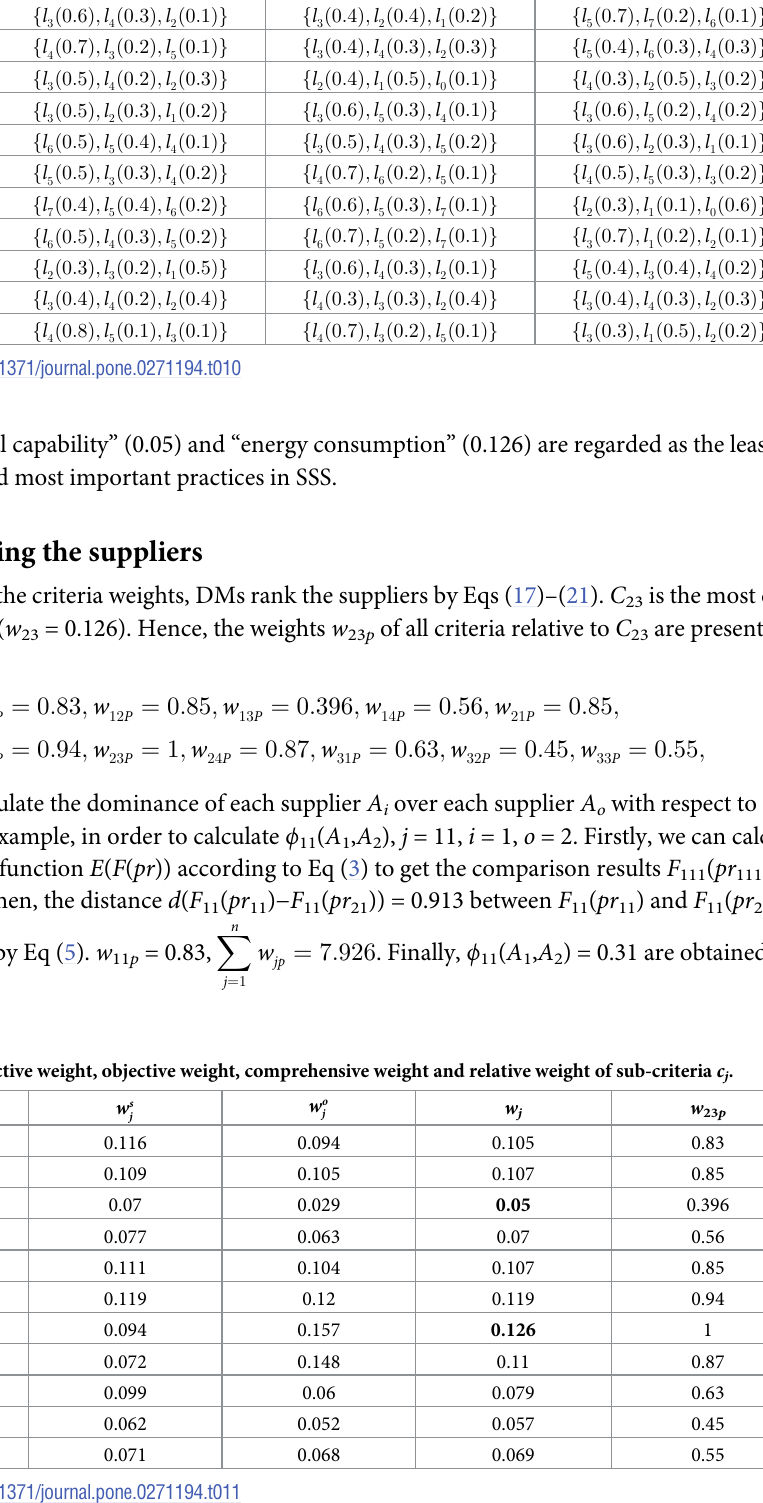
Table 9. Normalized group decision matrix in PLTS.